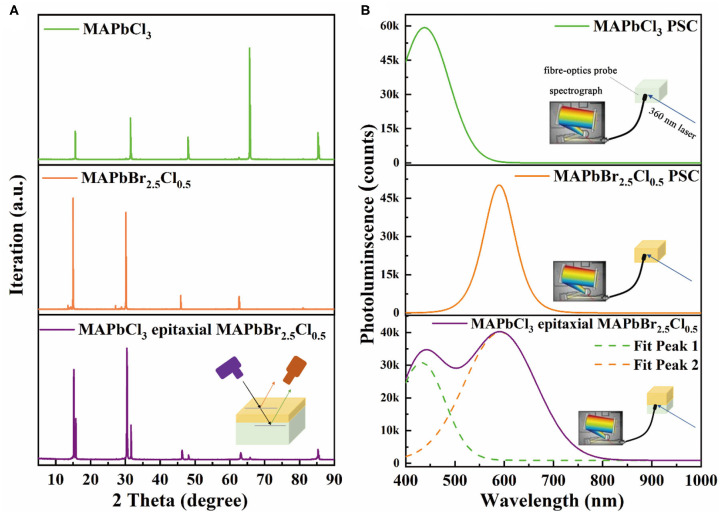
(A) XRD spectra and (B) PL spectra of MAPbCl3 PSC, MAPbBr2.5Cl0.5 PSC, and MAPbCl3 PSC on epitaxial MAPbBr2.5Cl0.5. Insets: the schematic diagram of PL spectra test.